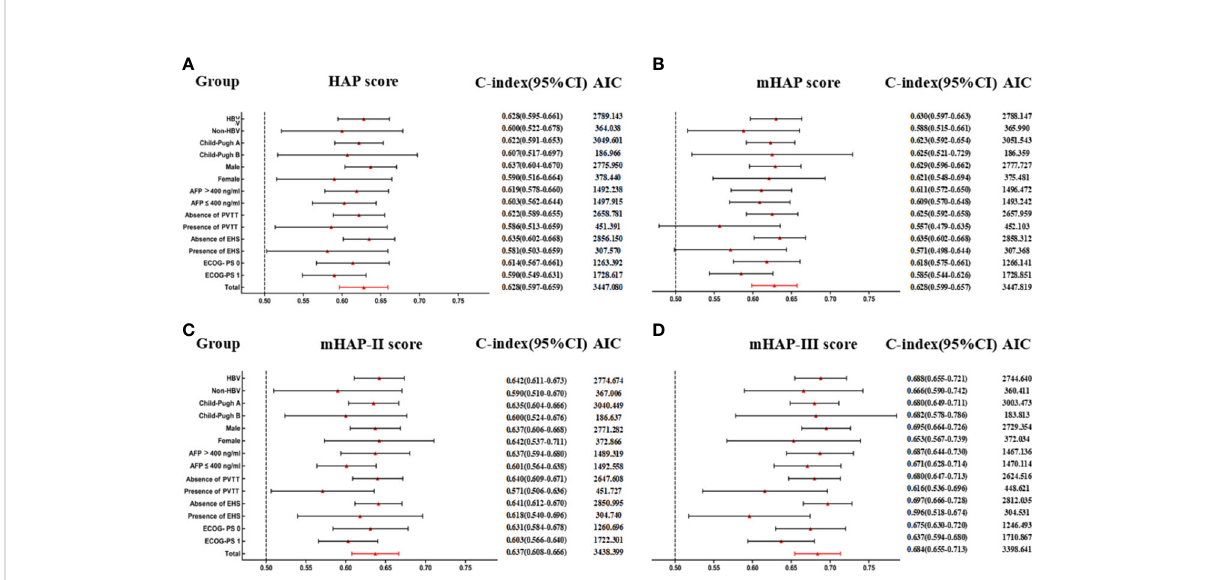
FIGURE 5 Subgroup analyses for HAP series scores to predict OS. (A) Predictive ability of HAP score in different subgroups. (B) Predictive ability of mHAP score in different subgroups. (C) Predictive ability of mHAP-II score in different subgroups. (D) Predictive ability of mHAP-III score in different subgroups. AIC, Akaike information criterion; HBV, hepatitis B virus; AFP, a -fetoprotein; ECOG, Eastern Cooperative Oncology Group; PS, performance status; HAP, hepatoma arterial-embolization prognostic; mHAP, modi fi ed